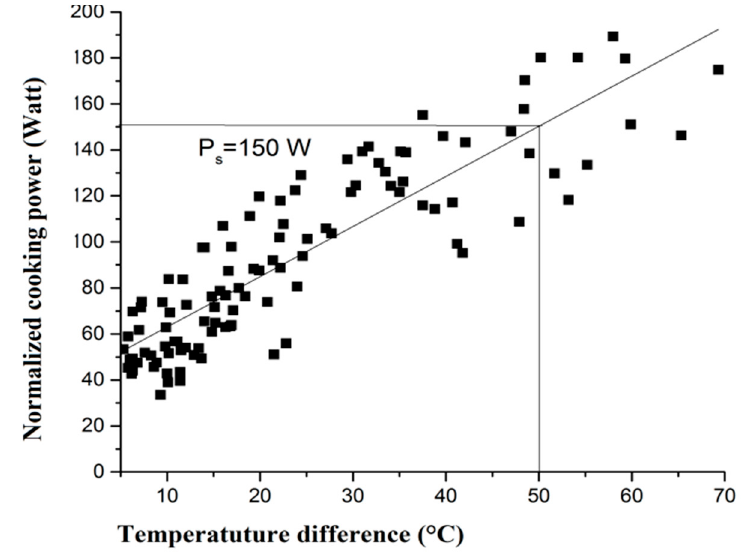
Figure 6. Experimental data to determine standard cooking power.